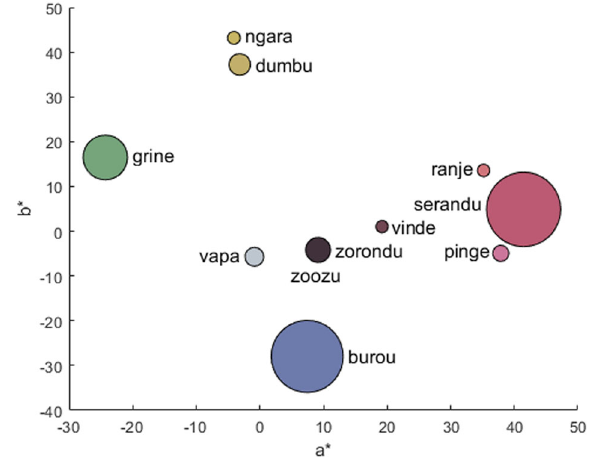
Fig. 1 Centroids of most frequent (> 3%) Himba colour terms in a* vs. b* planes of CIELAB. The size of each disc corresponds to the frequency of occurrence of the term. The colour of each disc corresponds to the centroid of each colour